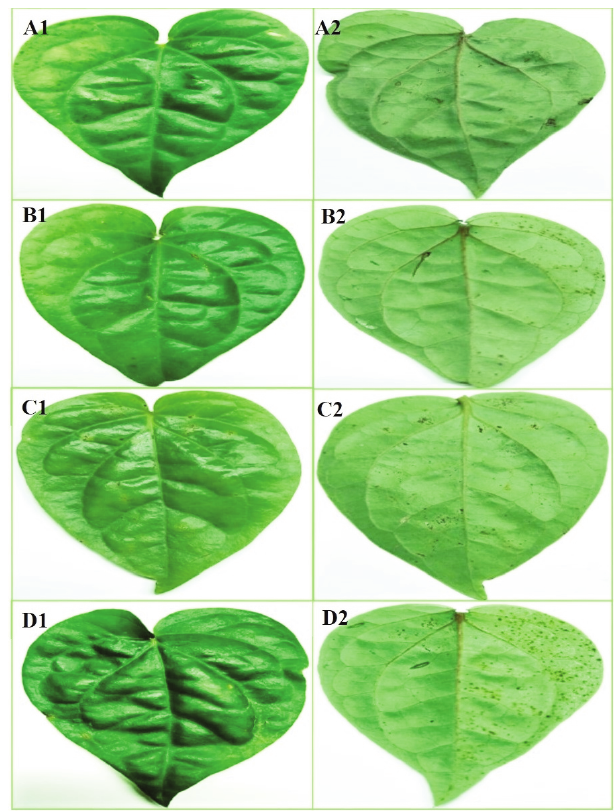
Fig. 1 ­ Major varieties of Piper betle (A1) ventral and (A2) dorsal side of ‘Bali’, (B1) ventral and (B2) dorsal side of ‘Chandrakana’, (C1) ventral and (C2) dorsal side of ‘Godi Bangala’, (D1) ventral and (D2) dorsal side of ‘Sanchi’ cul­ tivated in coastal region of the Odisha.